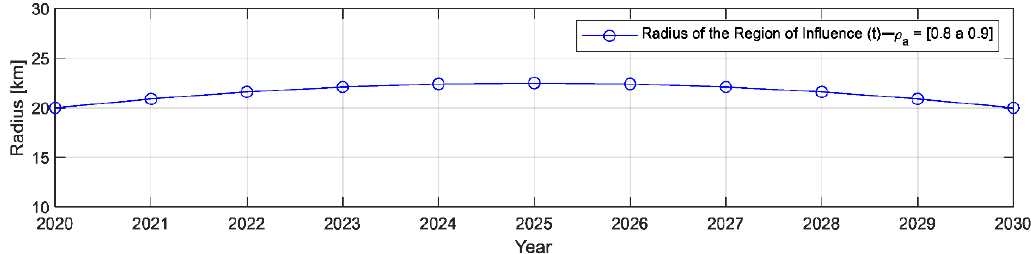
Figure 11. Radius of influence of the EV fast charging stations of project.